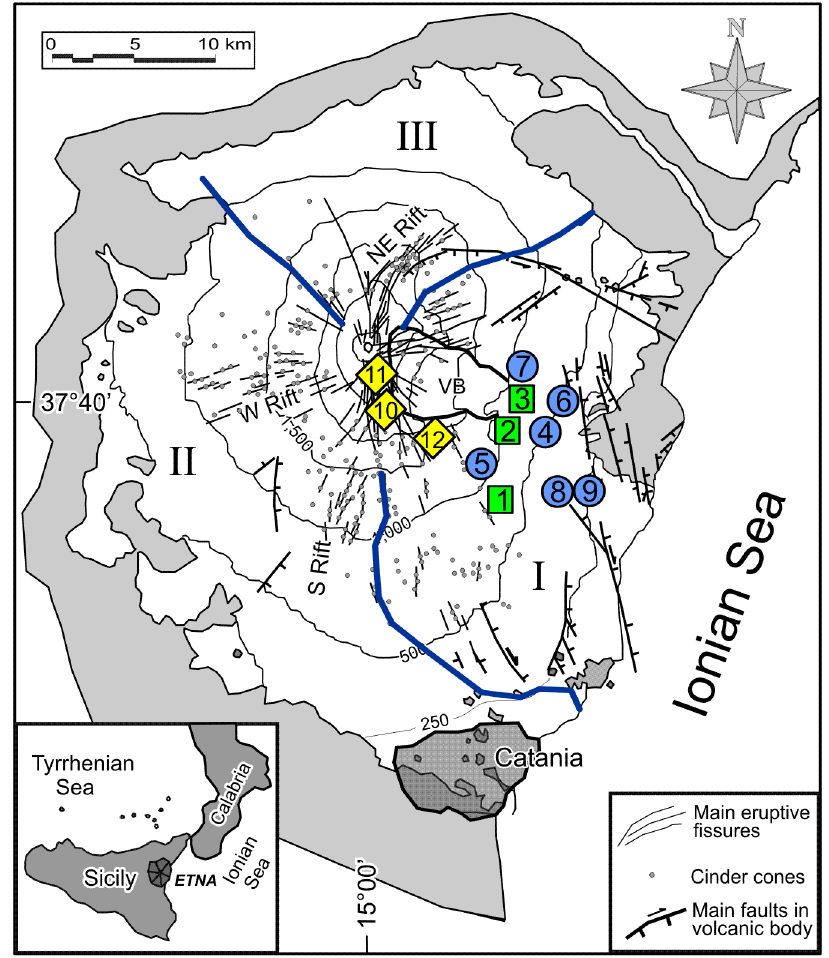
Figure 1. Map of study area and sampling sites. Green squares represent water drainage galleries; blue open circles represent water wells; yellow open diamonds indicate the location of the three lava rock samples taken near the summit area of the volcano. The three main hy- drogeological basins of the volcano (I = eastern basin; II = western basin; III = northern basin, according to Ferrara [1990]), delimited by thick blue lines, are also shown together with the three main rift zones (NE Rift, W Rift and S Rift, respectively). VB = Valle del Bove mor- phological depression. Volcano-tectonic data of Mt. Etna modified from Acocella and Neri